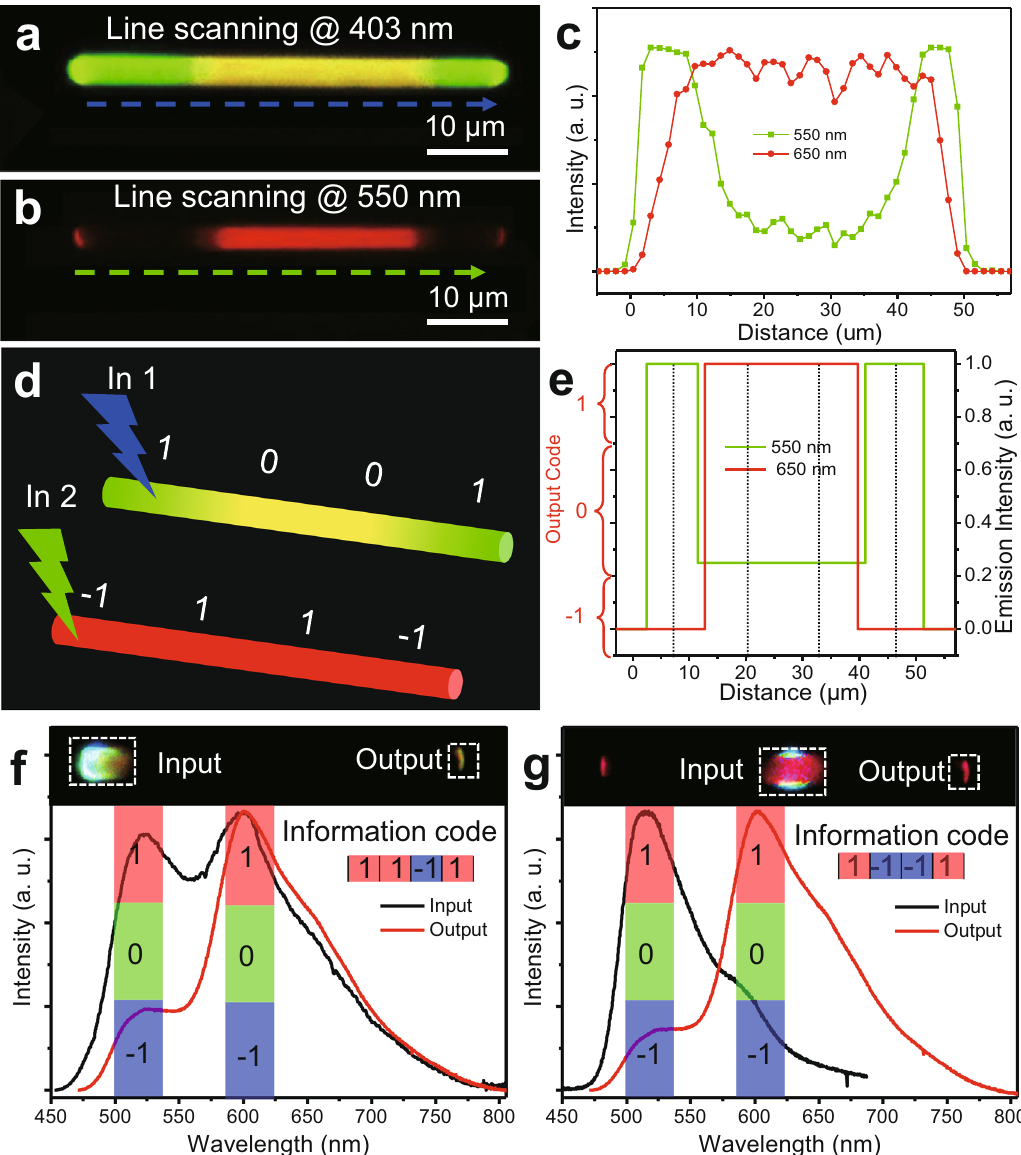
Fig. 6 Organic superstructure microwires for optical logic gate. a , b FM images of individual segmented-core/shell type-I organic microwires excited by the a UV light and b green light. The scale bars are 10 μ m. c The corresponding plots of the spatially emissive intensity as a function of the distance d along the wire axis. d , e Schematic diagram of d the luminescent barcode and e simulated decoding oscillography depended on the information on a – c . f , g Spatially resolved PL spectra collected from input and output channels after exciting with a laser beam ( λ = 375 nm) at the end part f and the centre part g . Inset: the corresponding FM